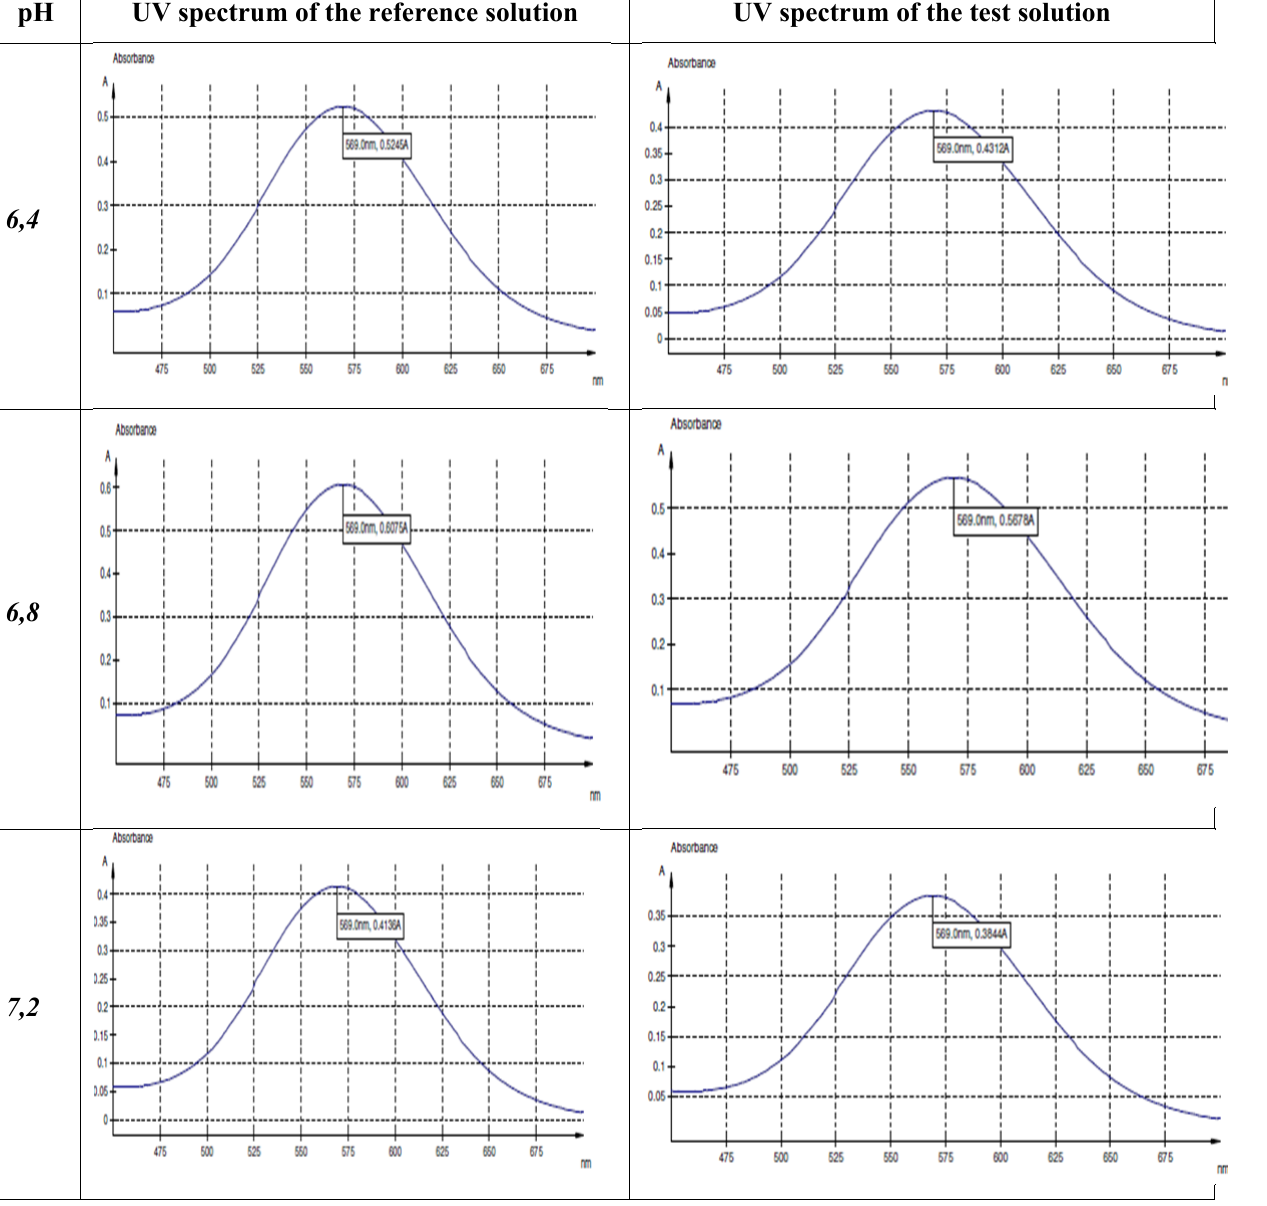
Fig. 1. Spectra of the reference solution and the test solution at different